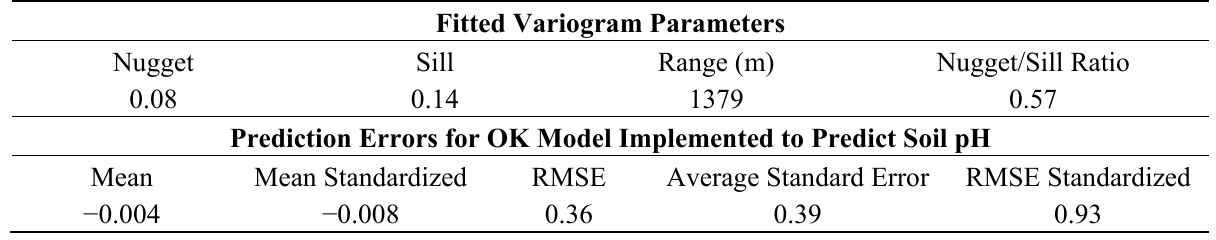
Table 2. Fitted variogram parameters and prediction errors for OK model for prediction of soil pH.